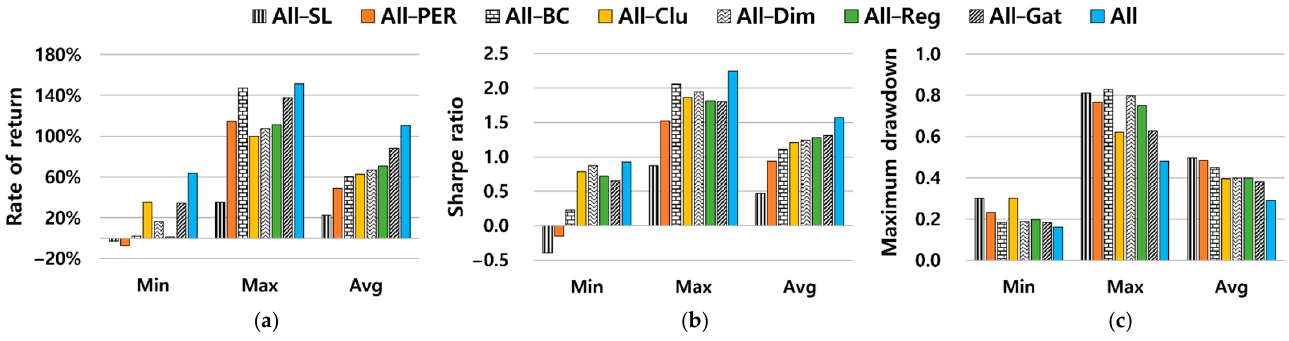
Figure 13. Experimental results of the ablation studies. ( a ) Rate of return. ( b ) Sharpe ratio. ( c ) Maximum drawdown.